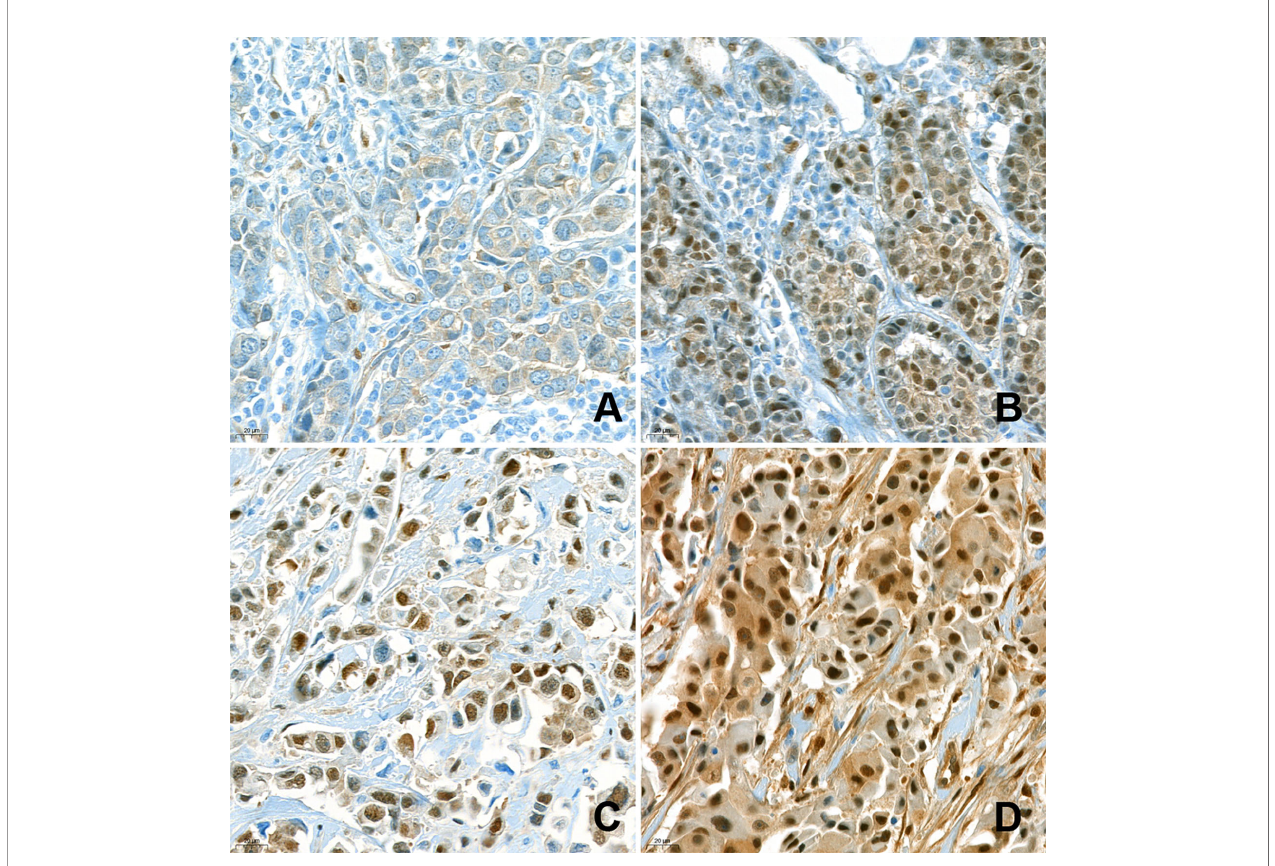
FIGURE 1 | Immunohistochemical analysis of nuclear YAP1 expression. Nuclear YAP1 expression was evaluated in high-power fi elds (400× magni fi cation) by an experienced pathologist. The samples were classi fi ed as negative (A) , 1+ (B) , 2+ (C) , and 3+ (D) , based on the intensity of YAP1 nuclear